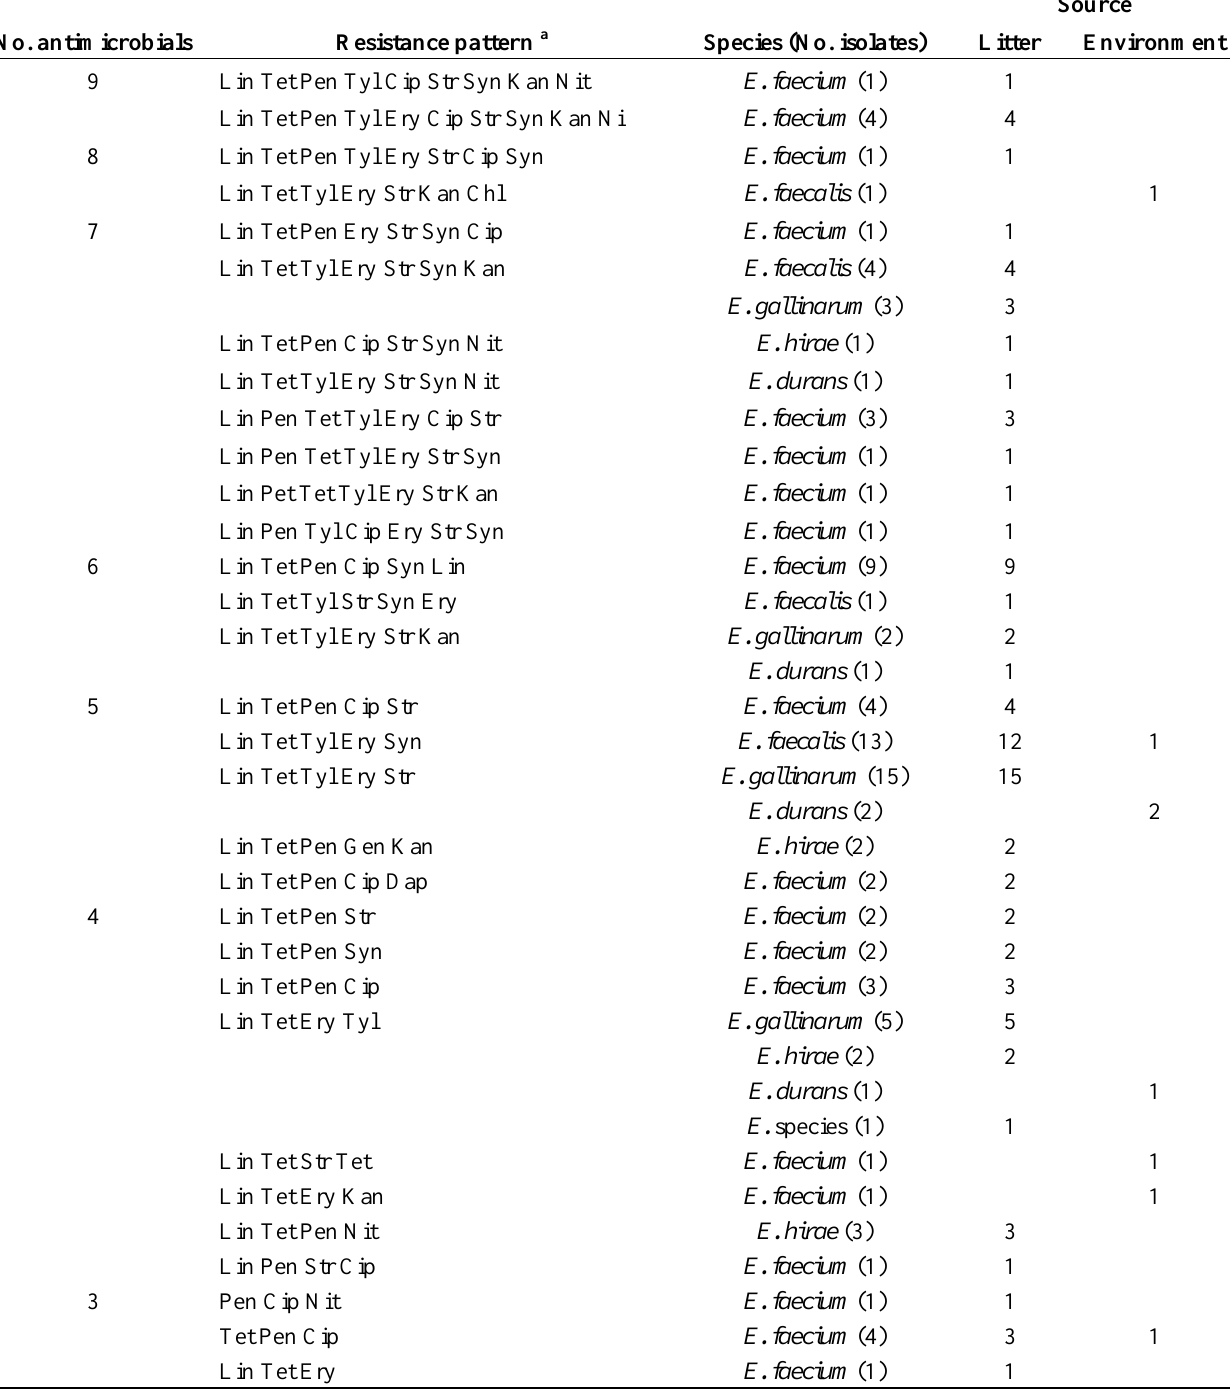
Table 3. Antibiotic resistance patterns for Enterococcus spp . in litter and